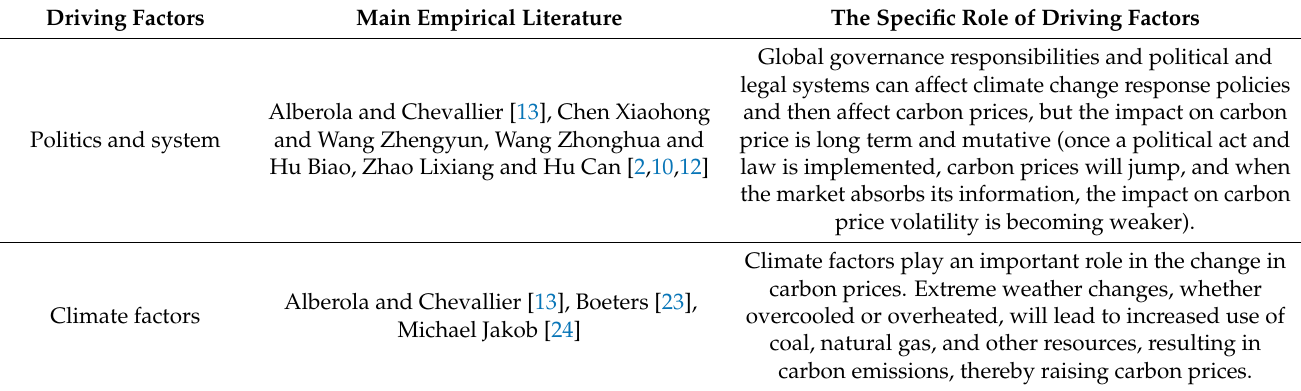
Table 1. Carbon price drivers for the price of carbon